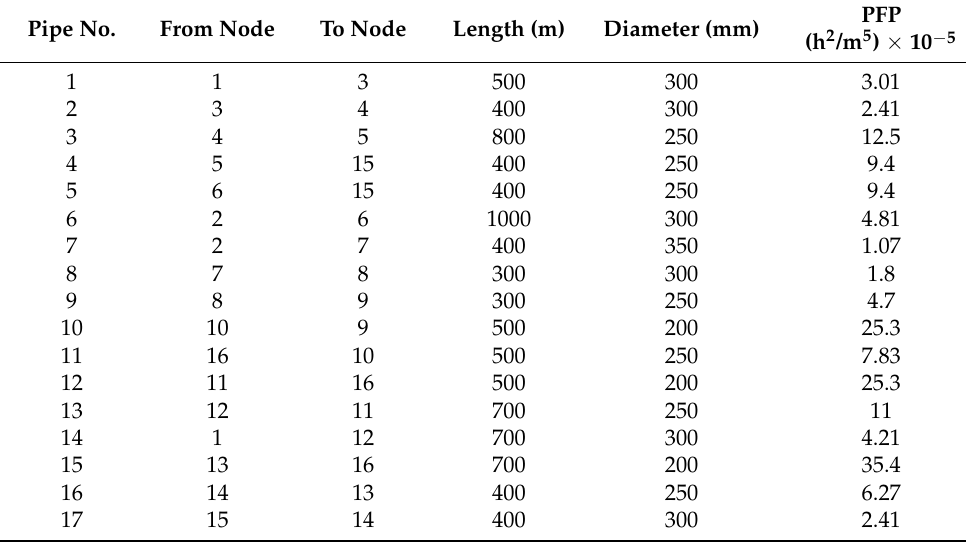
Table 3. Details of pipes in the simple actual HN.